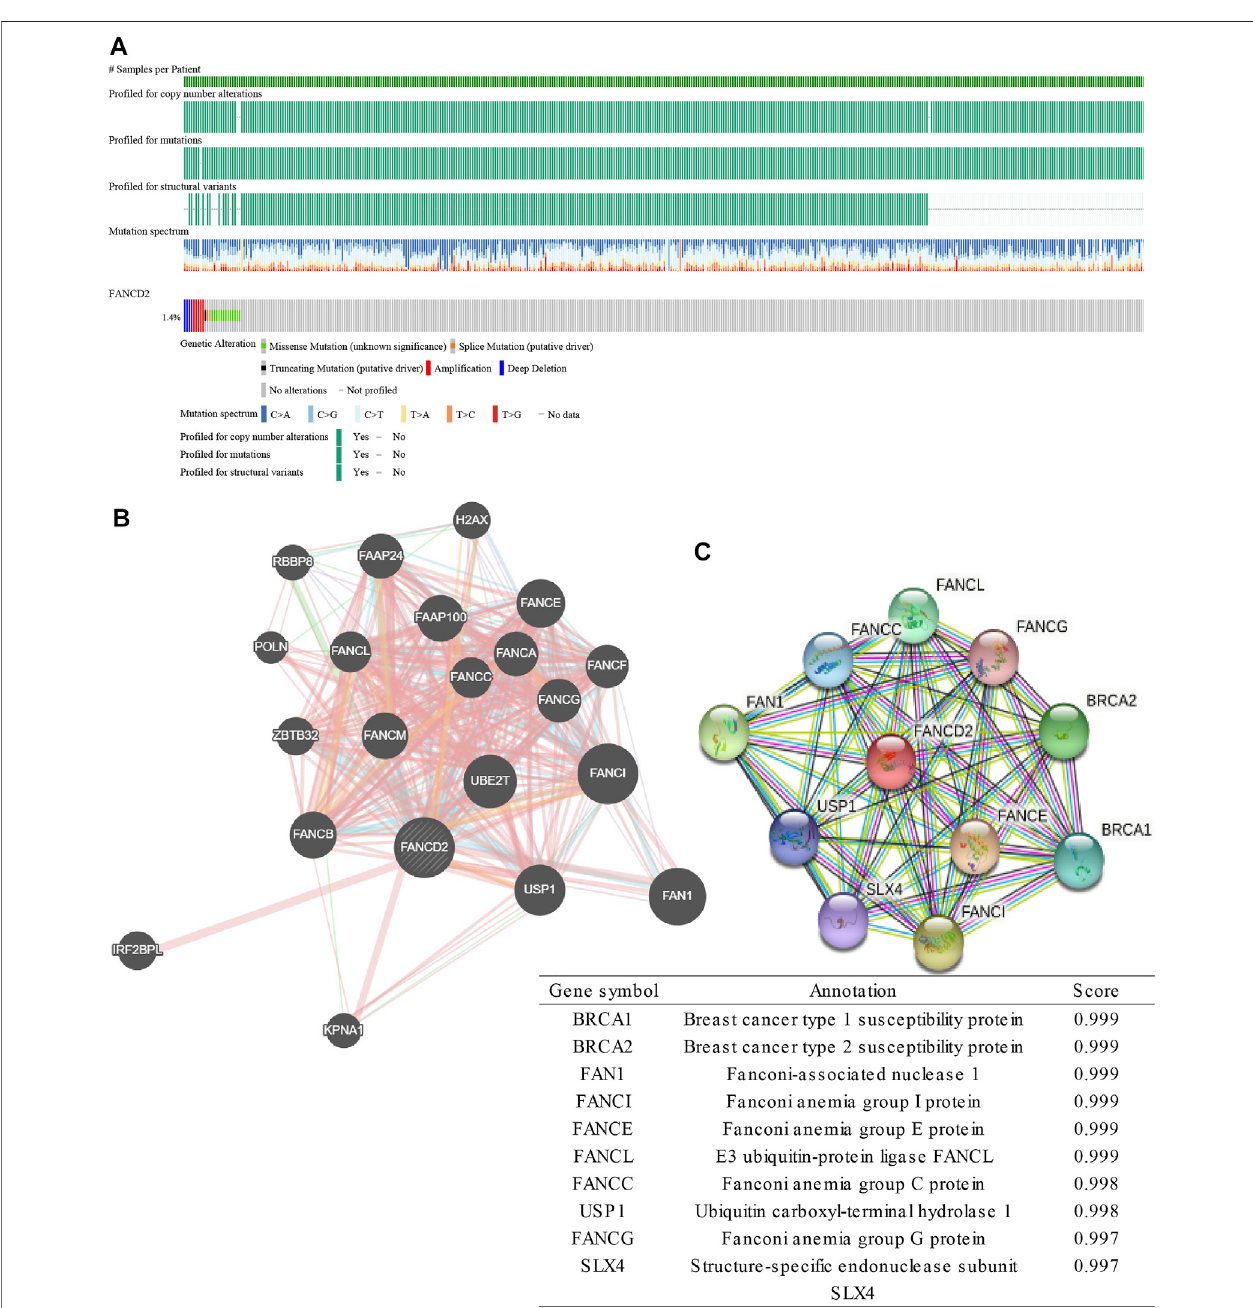
FIGURE6| GenomicalterationsofFANCD2andtheinteractionnetworkandproteininteractionnetworkofFANCD2. (A) GenomicalterationsofFANCD2basedon cBioPortal. (B) The gene – gene interaction network of FANCD2, as constructed with GeneMANIA. (C) The protein-protein network of FANCD2 is derived from STRING.